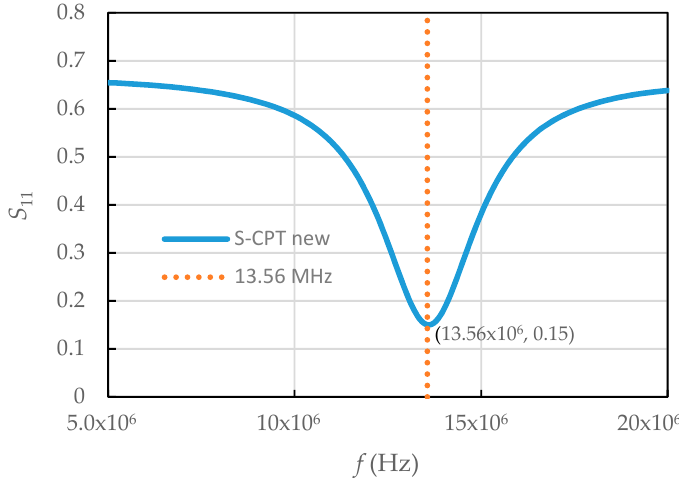
Figure 20. Impedance matching of S-CPT system at various frequencies.